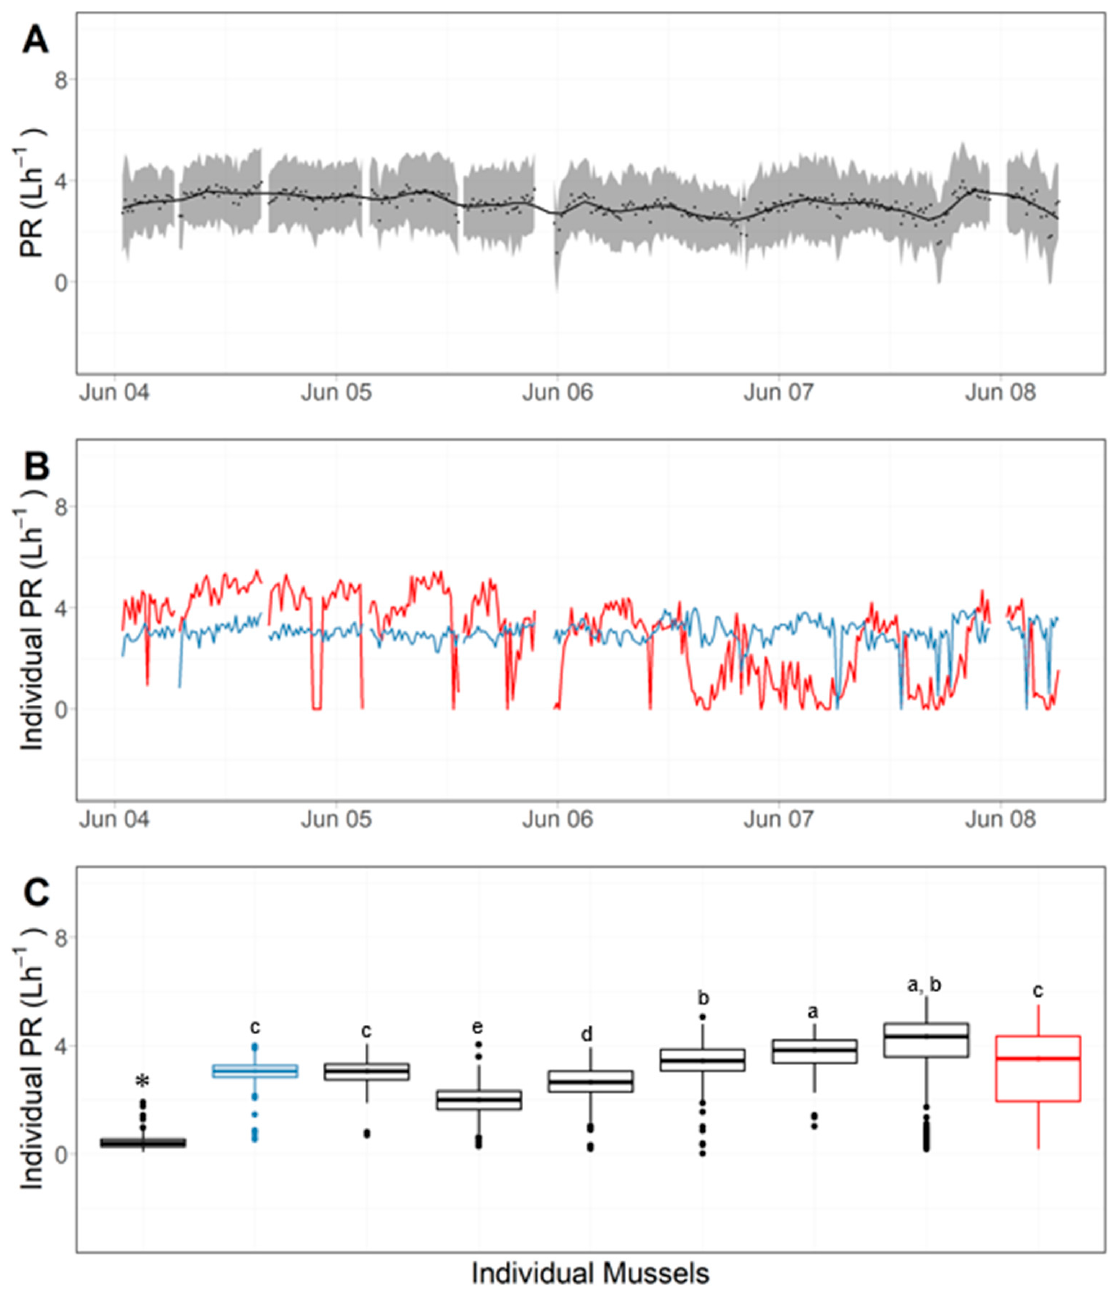
Figure 2. Summary of pumping rate (PR) (Lh − 1 ) data from Exp. 2: ( A ) median PR of all individuals ± SD over 4 days. ( B ) Individual PR of two mussels with low (blue) and high (red) interquartile range in PR. ( C ) Boxplots of the summarized PR of all individuals over the entire experiment; letters a–e above boxplots indicate statistically significant differences at p < 0.0001. * Indicates individual mussel not included in median measurements.